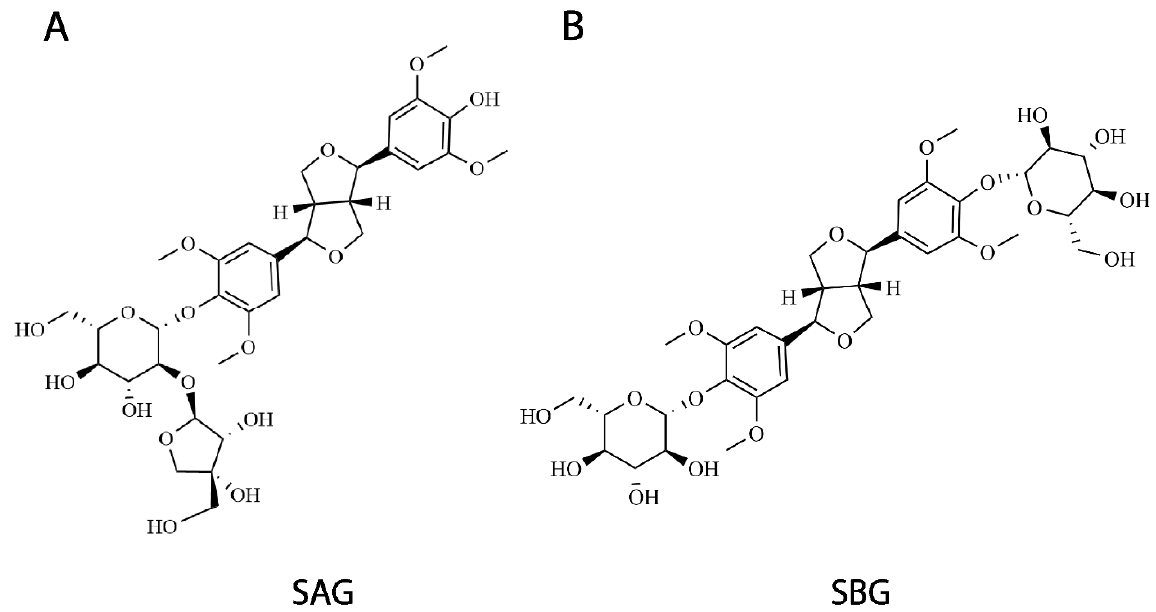
Figure 2. Structures of two lignan glycosides isolated in this study. Total extracts of Albizia julibrissin Durazz. successively separated by nonpolar macroporous adsorption, high-speed countercurrent chromatography, and preparative chromatography, and inhibitory effects of all fractions on hSERT activity were monitored as described in Section 4. Two compounds, ( A ) SAG and ( B ) SBG, with strongest potency antagonizing hSERT activity identified by structural analyses.